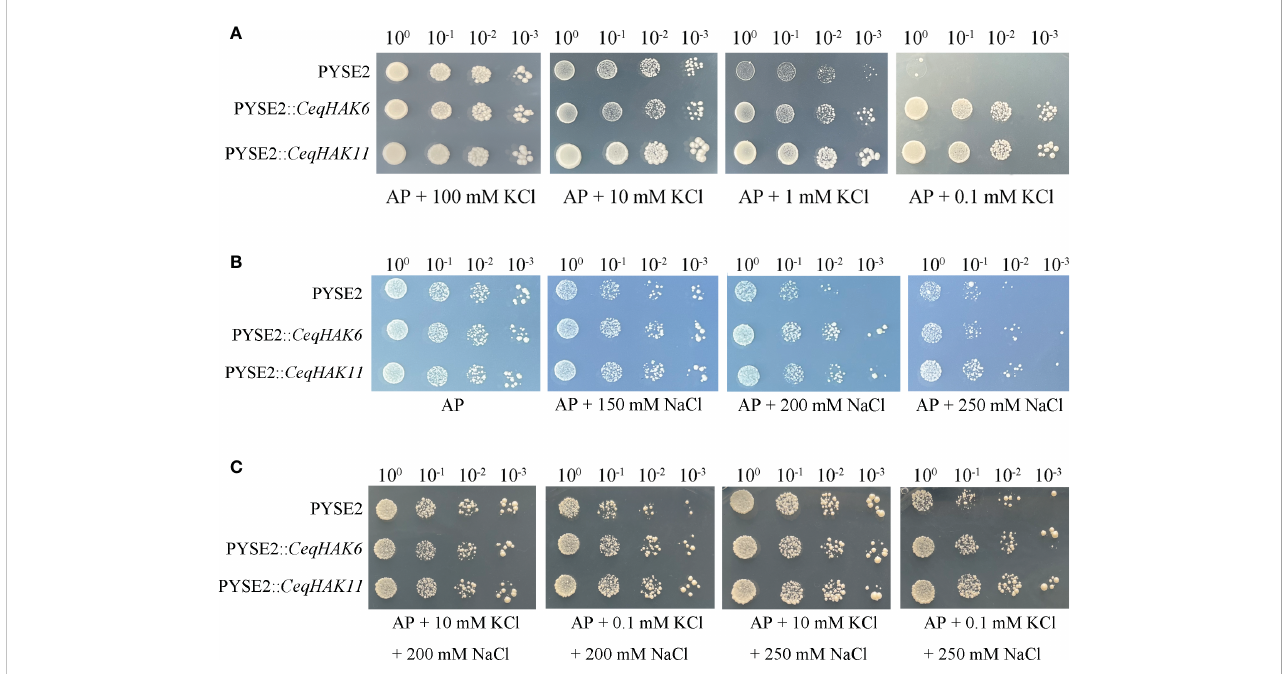
FIGURE 5 Functional characterization of CeqHAK6 and CeqHAK11 expressed in yeast strain. (A) Growth inhibition tests of yeast strain R5421 (MAT a ura3-52 leu2 trk1 D his3 D 200 his4-15 trk2 D 1::pCK64) expressed the CeqHAK6 gene, CeqHAK11 gene and empty vector pYES2. (B, C) Growth of yeast strain BY4741 (MATa his3 D 1 leu2 met15 D ura3-52) cells harboring the CeqHAK6 gene, CeqHAK11 gene and empty vector pYES2. All transformants were grown on AP medium with different contents of Na + and K + . Three independent experiments were